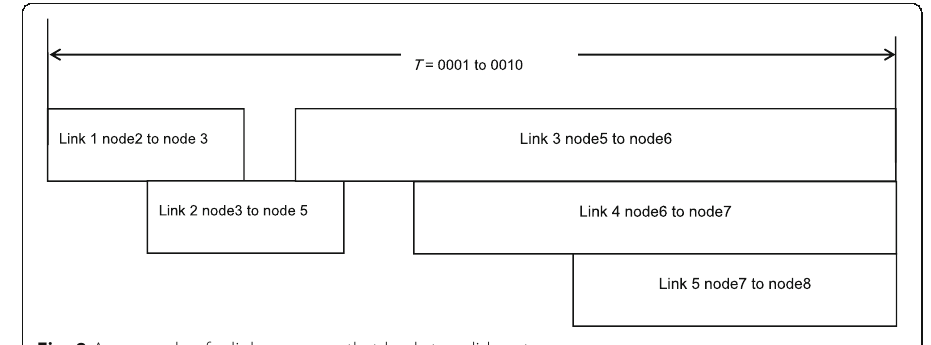
Fig. 8 An example of a link sequence that leads to valid route